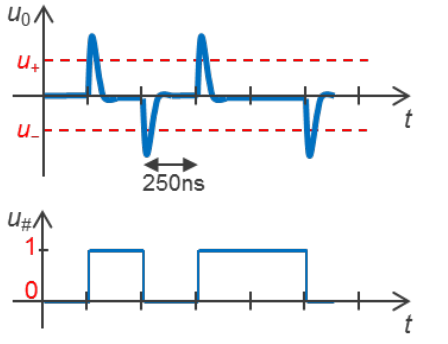
Figure 4. Synchronization and communication signals u 0 and u #